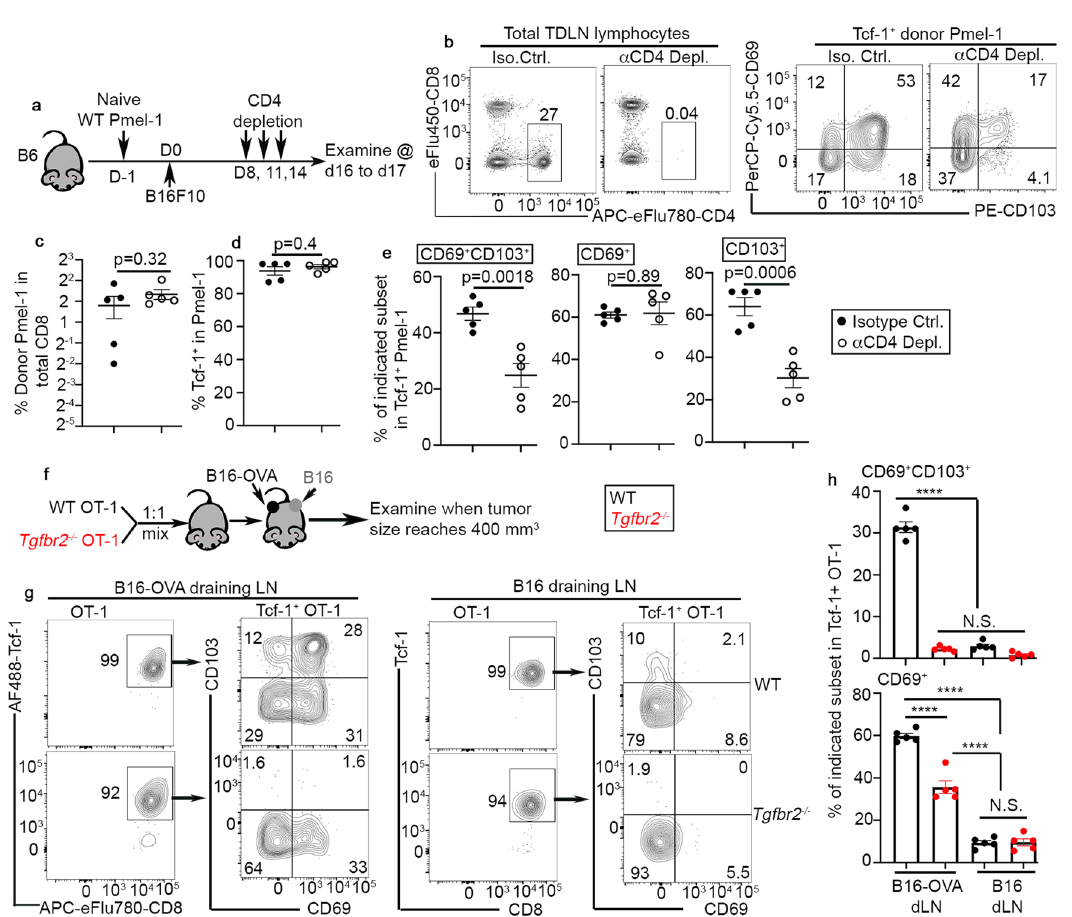
Fig. 5 | CD4 help, tumor antigen, and TGF- β -dependent establishment of TRM stem-likeTcellsinTDLN.a Experimentaldesignfor( b )to( e ).Filledcircle,control and empty circle, CD4 depleted. b Representative FACS pro fi les of total TDLN lymphocytes (left) and pre-gated Tcf-1 + Pmel-1 T cells (right) are shown. c The per- centageofPmel-1TcellsintotalTDLNCD8 + Tcellsareshown. d Thepercentageof Tcf-1 + cells in TDLN Pmel-1 T cells are shown. e The percentage of CD69 + CD103 + (left),CD69 + (middle), and CD103 + (right) inTcf-1 + Pmel-1 T cellsare shown.For ( c ) to ( e ), n =5/each. f Experimental design for ( g ) and h . Black, WT and red, Tgfbr2 − / −